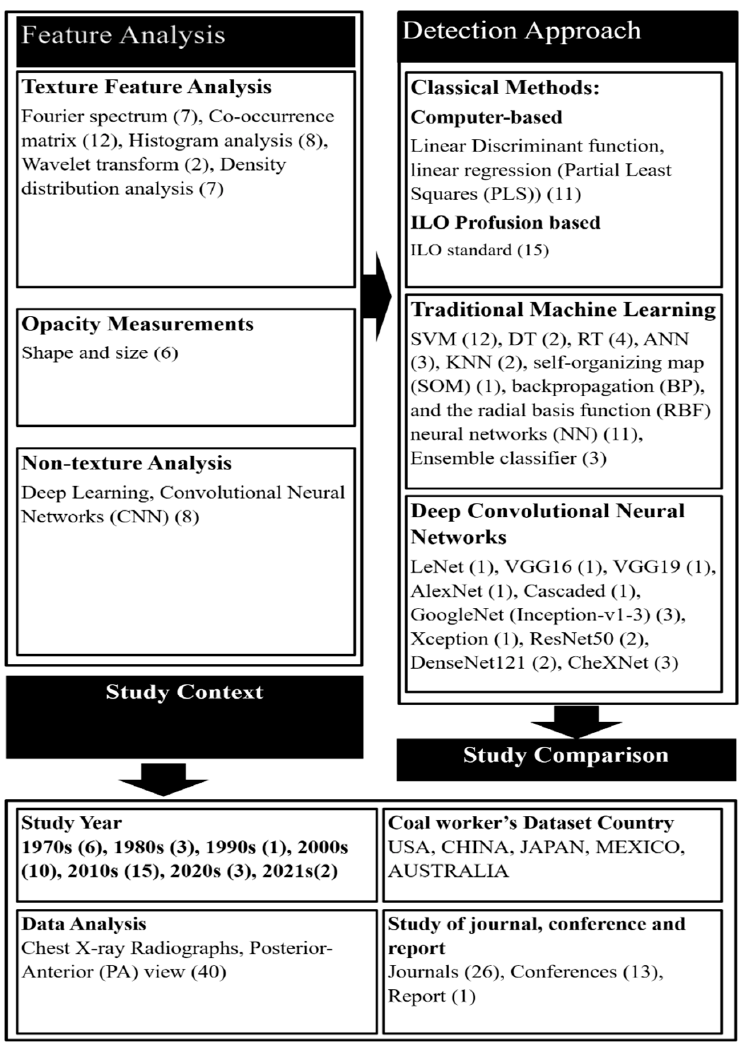
Figure 3. Theoretical framework for the CAD of CWP based on machine learning.